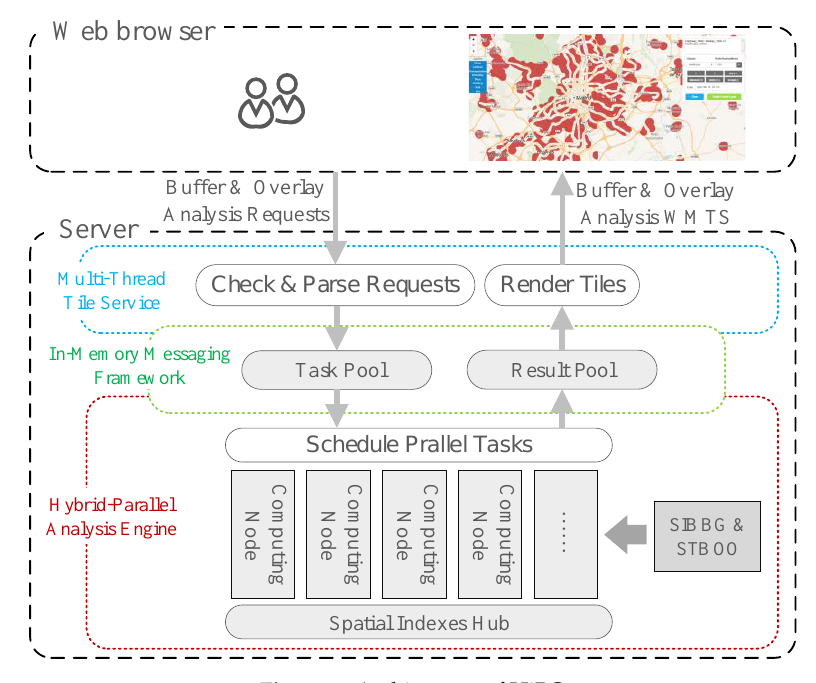
Figure 6. Architecture of